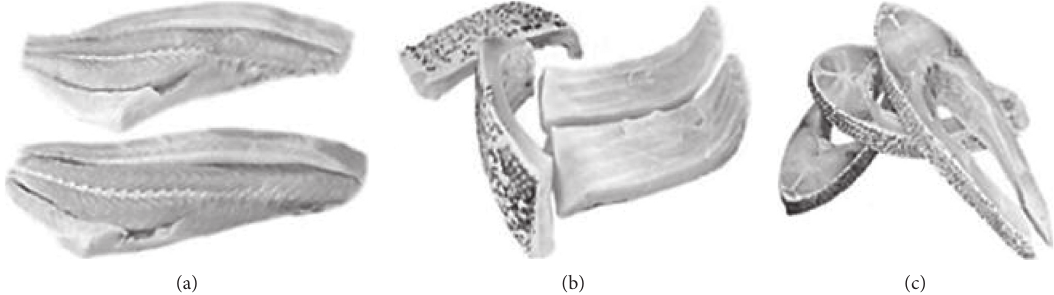
Figure 1: Initial processing of black pacu ( Colossoma macropomum ) and cut commercialized in the Rondˆonia state, Amazon, Brazil. (a) Fillet with skin, (b) ribs, and (c)